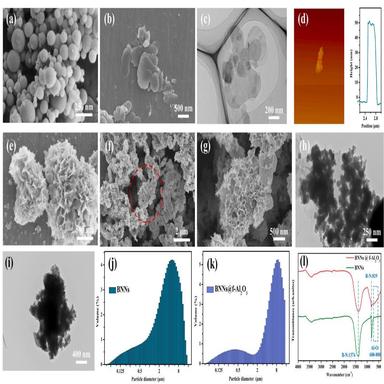
The SEM images of (a) nano spherical aluminum powder, (b) s-BNNs, (e) flower-like Al2O3 fabricated by single nano spherical aluminum powder, (f, g) BNNs@f-Al2O3 with different magnification; TEM images of (c) BNNs with several layers, (h) BNNs@f-Al2O3 powders, (i) flower like Al2O3 powders; (d) AFM image and height variation of s-BNNs; Particle size distribution of (j) s-BNNs, (k) BNNs@f-Al2O3; (l) FTIR spectra of BNNs and BNNs@f-Al2O3.